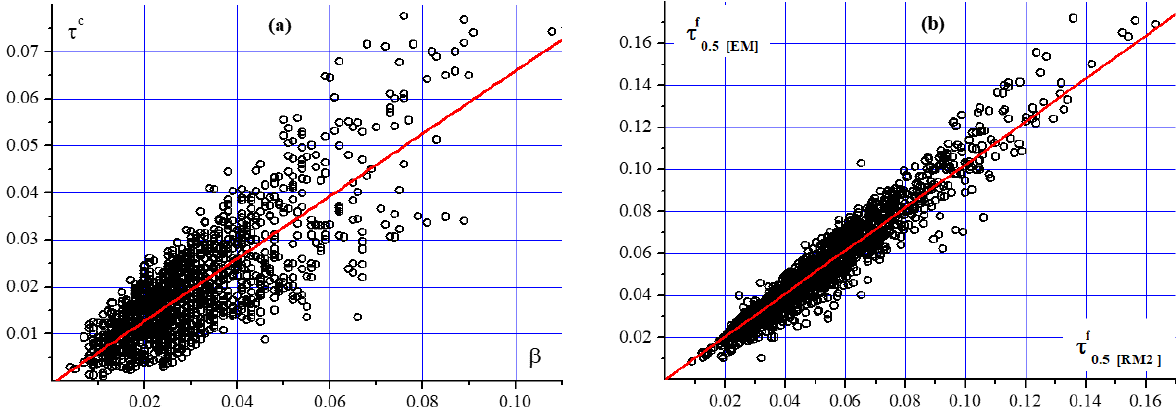
Figure 3. (a) The interrelation of τ c with the β parameter, and (b) the interrelation of τ f RM2 methods.